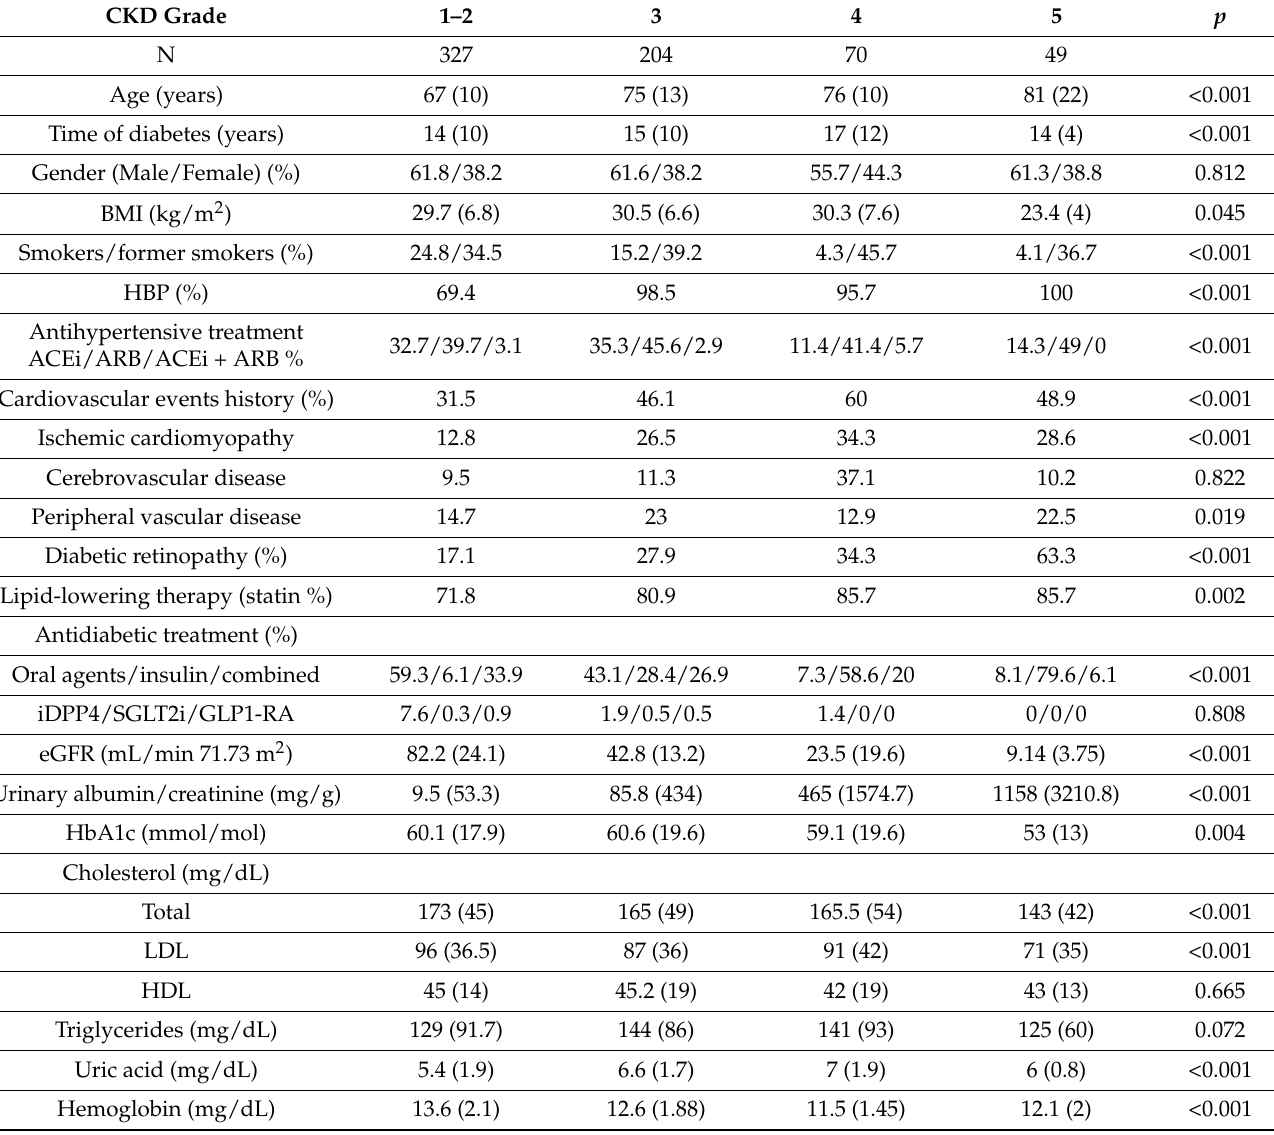
Table 1. General characteristics at baseline visits by grades of chronic kidney disease.